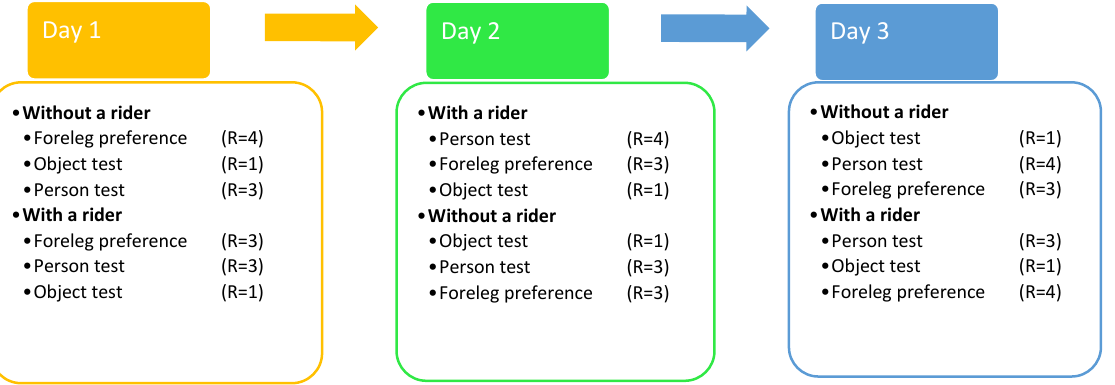
Figure 1. Example of the experimental timeline for each horse. The figure presents a visualisation of the experimental procedure over the three days, showing an example of the order and the number of repetitions (R) of the experiments conducted with a rider (E1) and without (E1) for one particular horse within a day. The single experiments are named as follows: motor laterality foreleg preference test (foreleg preference); sensory laterality person test (person test); and sensory laterality object test (object test). The order of the experiments was chosen by random for each particular test horse so that further horses would complete the same tests but in a different order.